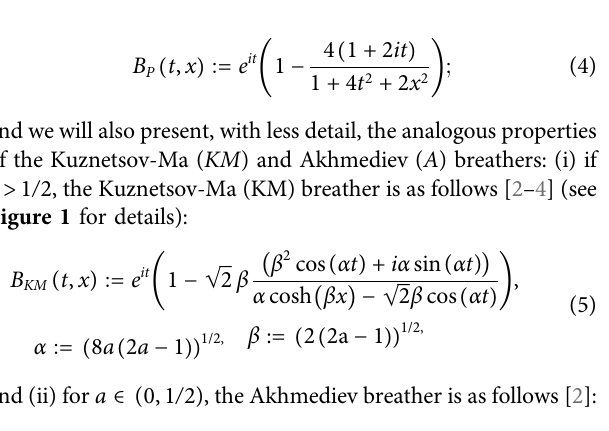
FIGURE 1 | Left: absolute value | B P | of the Peregrine breather Eq. 4 . Center: | B KM | , Eq. 5 . Right: | B A | Eq. 6